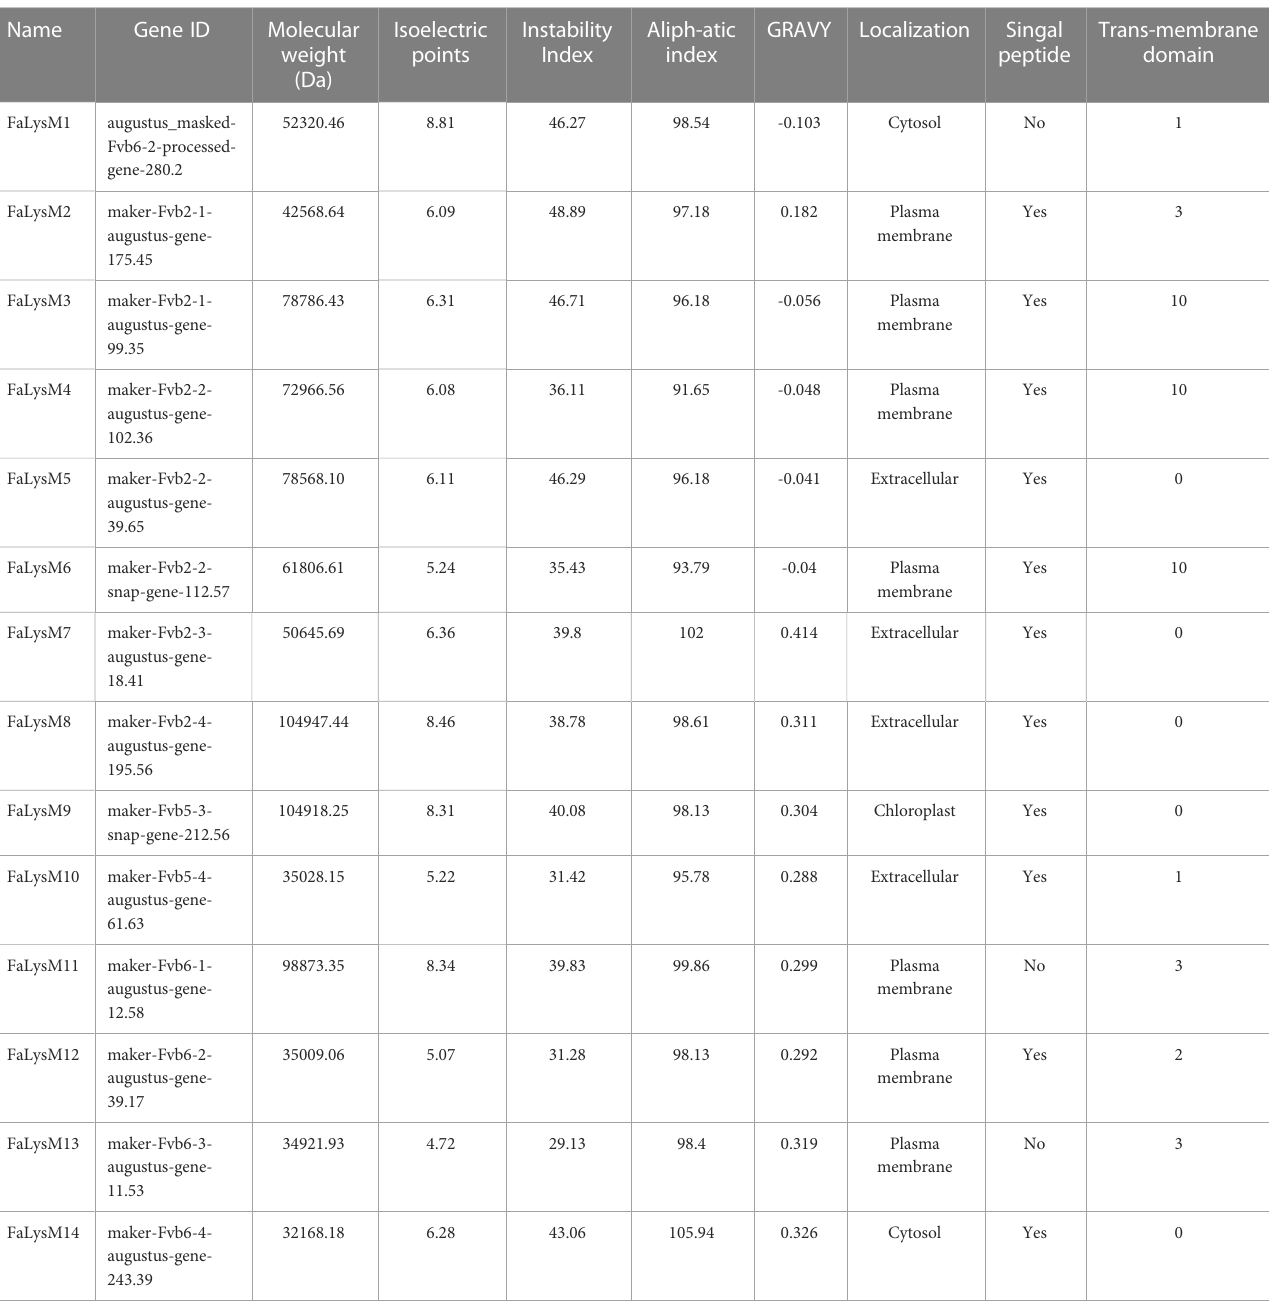
TABLE 1 Features of octoploid strawberry LysM proteins (FaLysM).